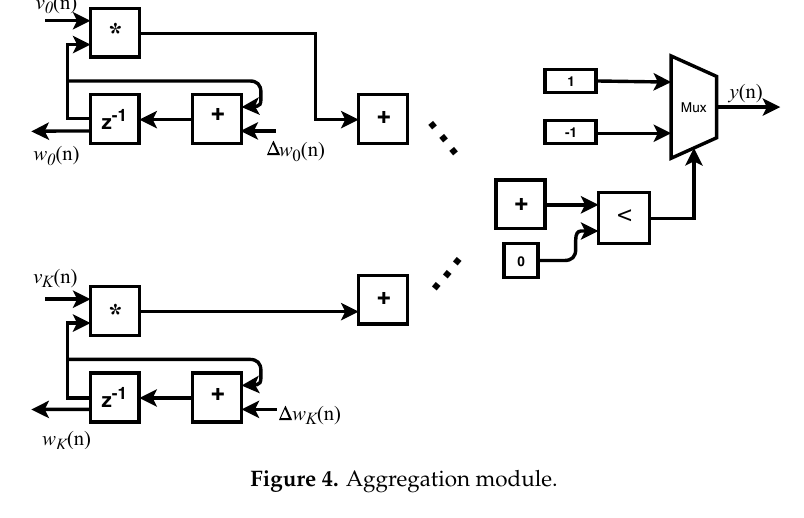
Figure 4. Aggregation